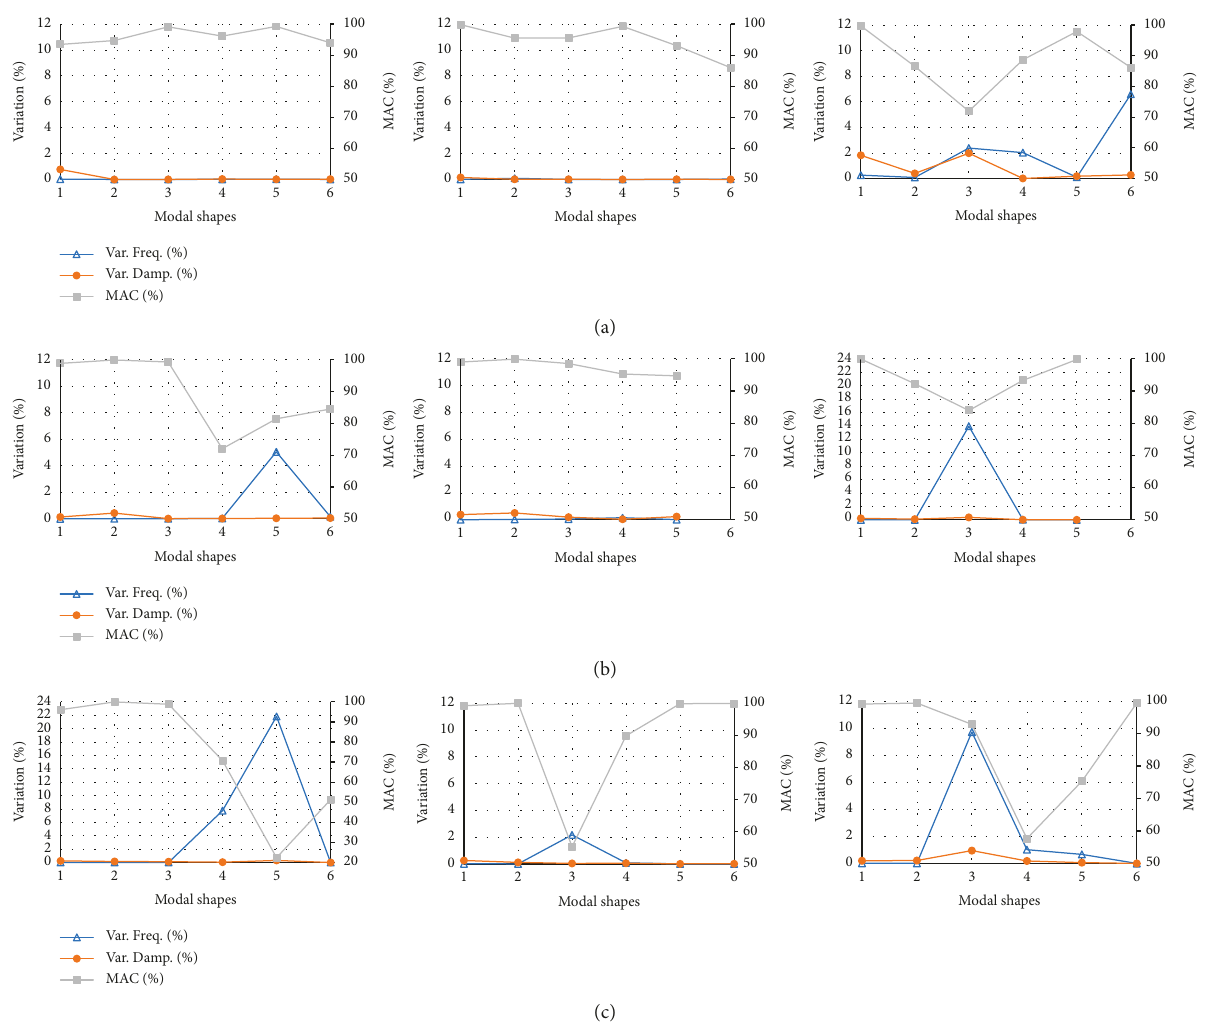
Figure 6: (a) B1-imperfection indicators; (b) B2-imperfection indicators; (c) B3-imperfection